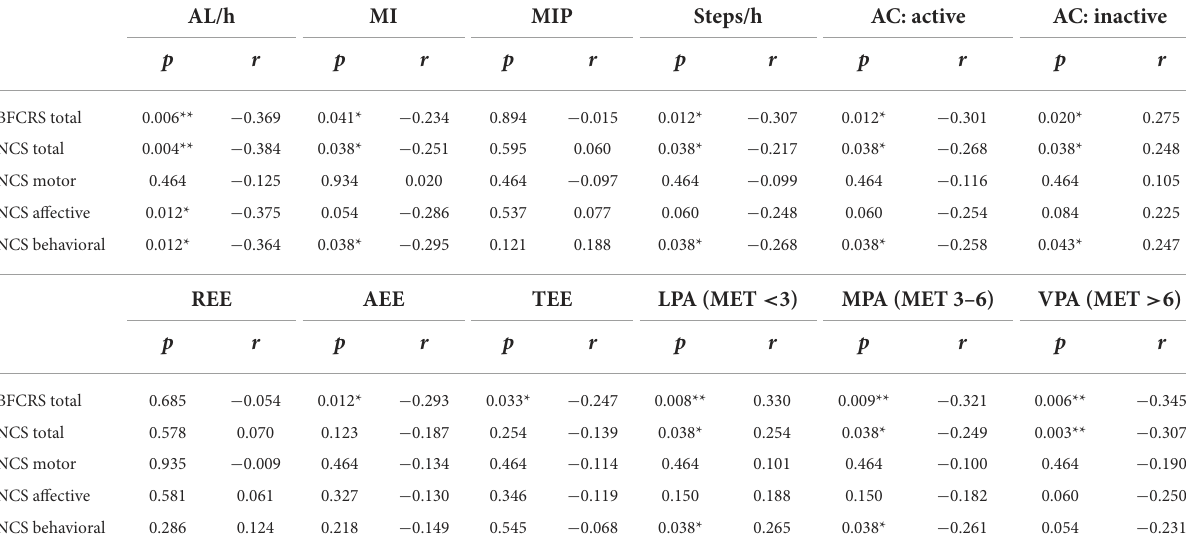
TABLE 3 Catatonia total and subscore correlations with actigraphy parameters controlling for age, medication (OLZ eq.), and body mass index (BMI). AL/h MI MIP Steps/h AC: active AC: inactive